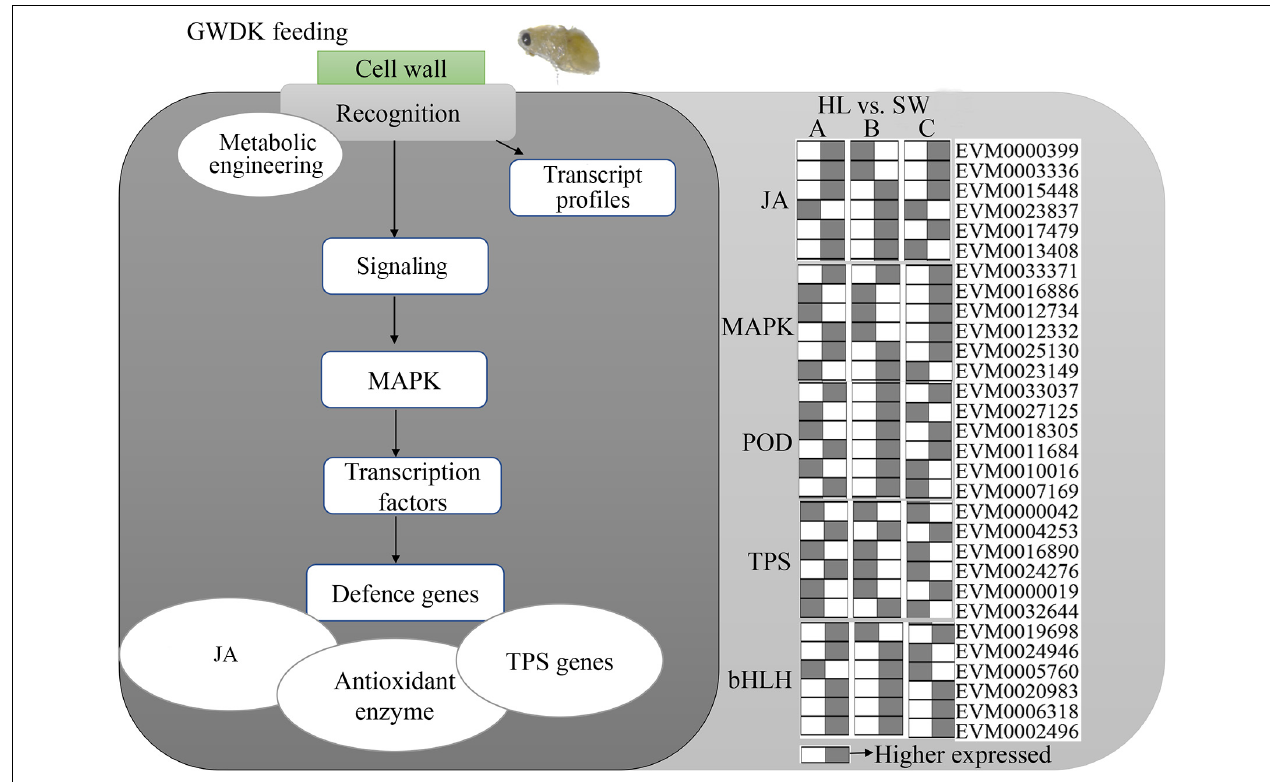
FIGURE 9 | Genetic model of Chinese chestnut buds responses upon GWDK infestation. The heatmap includes the top 6 highest expressed genes in jasmonic acid (JA), MAPK, POD, terpene synthase (TPS), and bHLH gene classes; gray color represents higher expressed of a certain gene compared with white